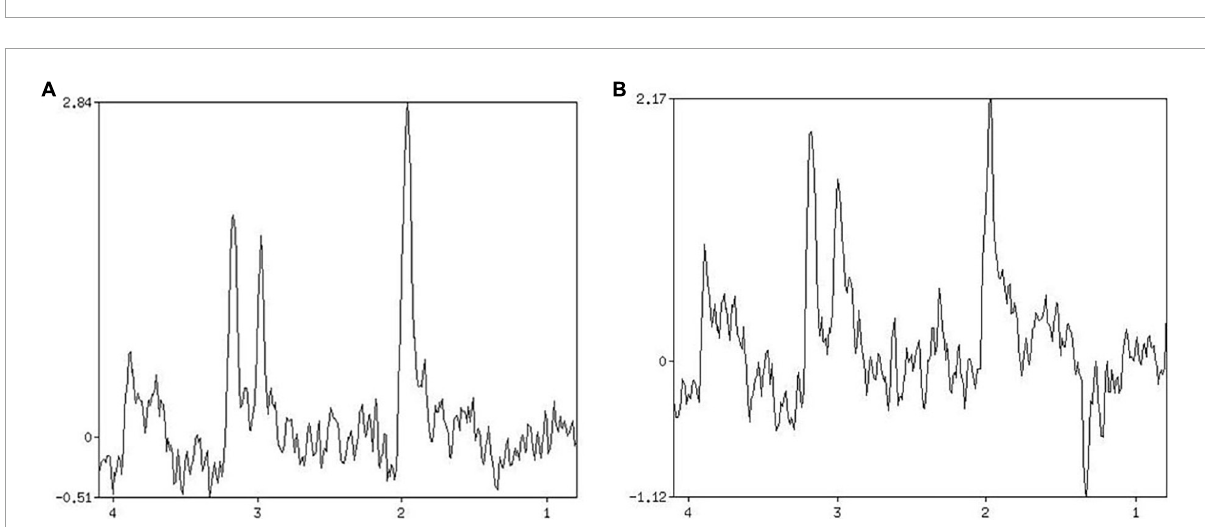
FIGURE3 Patient 2 HbAlc: 10.3. (A) MRS shows changes in brain metabolites in the infarcted area, NAA/Cr 1.906, Cho/Cr 0.926. (B) MRS shows changes in brain metabolites in the contralateral side at the same site, NAA/Cr 1.422, Cho/Cr 1.571.